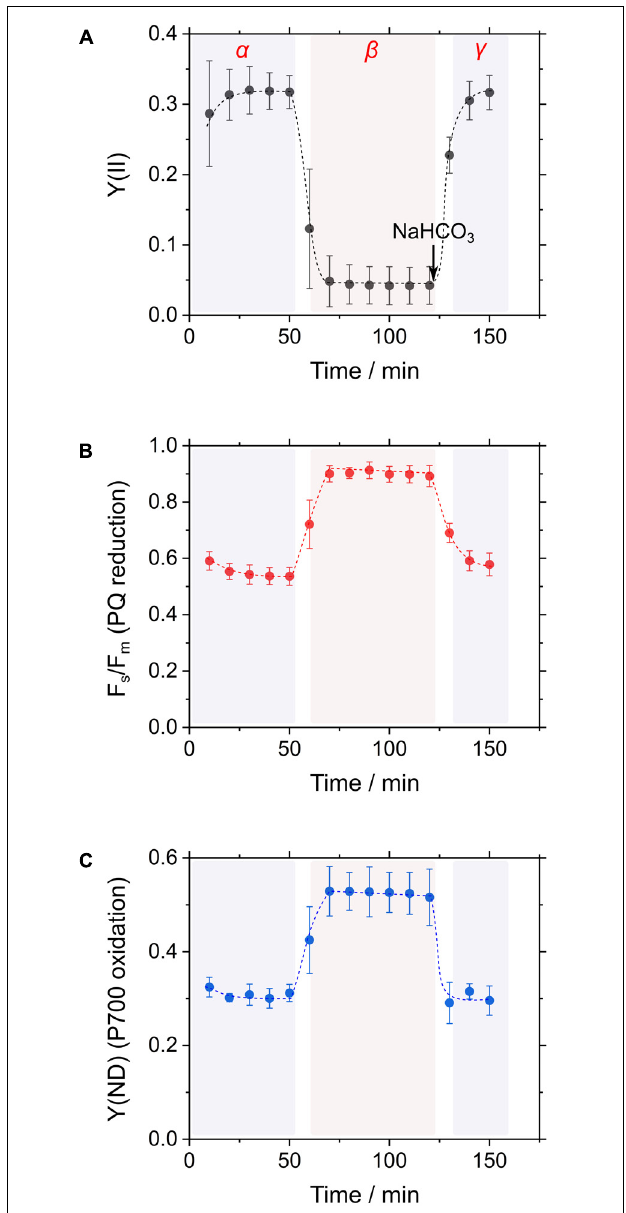
FIGURE 2 | Time courses of the incident quantum yield of PSII, Y(II) (A) , the chlorophyll fluorescence parameter inferring the reduction of the plastoquinone (PQ) pool, F s /F m (B) , and the electron donor-side limitation of photosystem I, Y(ND) (C) in response to CO 2 limitation in Synechococcus elongatus PCC 7942. Cyanobacterial photosynthesis starts at 0 min with an actinic light. Thereafter, Y(II) decreases due to a shortage of CO 2 , which is defined as the transition from phase α to β . The addition of CO 2 in the form of NaHCO 3 restores photosynthetic activity (phase γ ). Data are mean ± the standard deviation of three measurements (technical